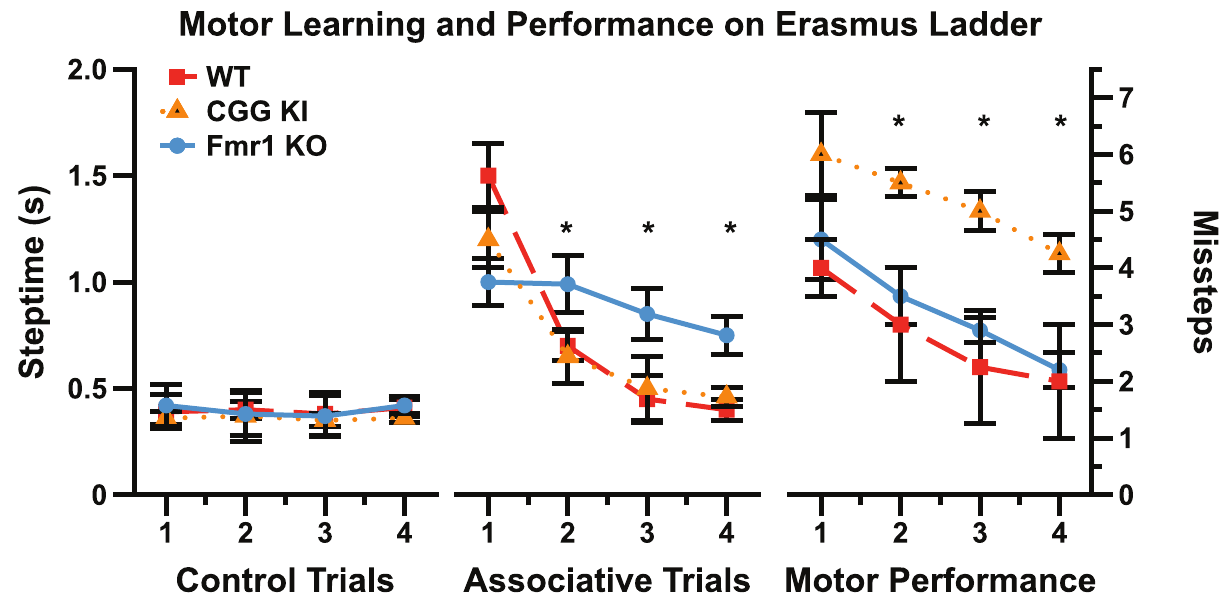
Figure 6. Data redrawn from Cupido (2009) 53 demonstrating the dissociation between motor performance and motor associative learning in CGG KI mice and the Fmr1 KO mouse model of Fragile X Syndrome. Note the dissociation between motor endophenotypes in the CGG KI and Fmr1 KO Mice. All CGG KI mice were from the High CGG repeat group in other